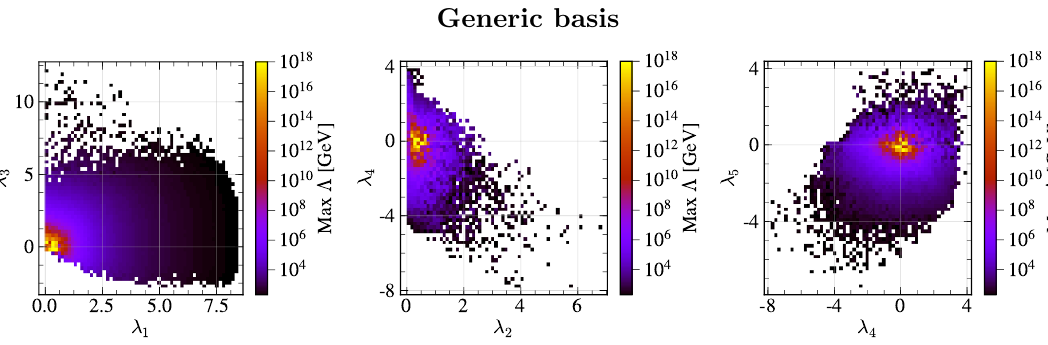
Figure 15 . The maximum breakdown energy scale as a function of quartic couplings in the generic basis in the parameter scan of scenario